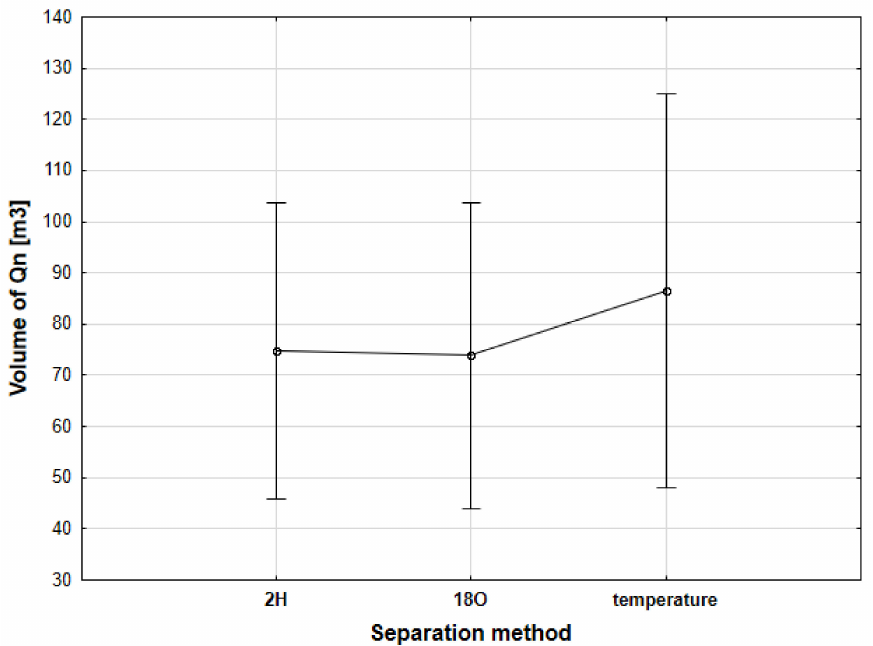
Figure 5. Evaluation of separation based on three tracers according to ANOVA with means and confidence intervals (mean ± 0.95 confidence interval).